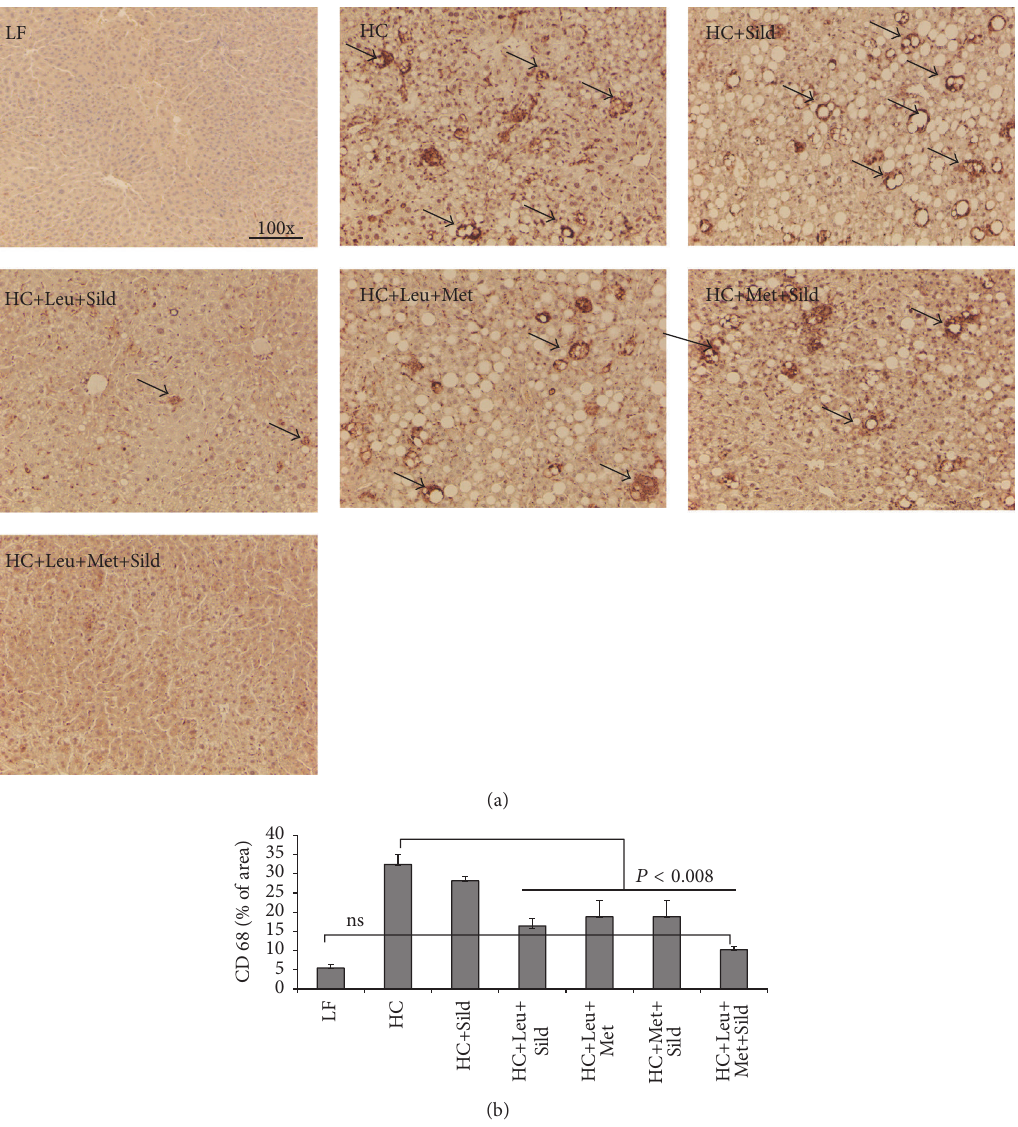
Figure 8: Sild-Met-Leu effects on liver Kupffer cell activation in mice. Mice were fed a low-fat (LF) diet or high-fat atherogenic (HC) diet for 6 weeks and then randomized to the indicated treatment groups for an additional 6 weeks. (a) Liver sections were stained with anti-CD68 antibody at the end of the study ( 𝑛 = 2 ). Representative images for each group are shown. (b) Quantitation of CD68 staining, calculated as % of the examined area. Data are expressed as mean ± SEM ( 𝑛 = 2 ). Sild: sildenafil, Met: metformin, Leu: